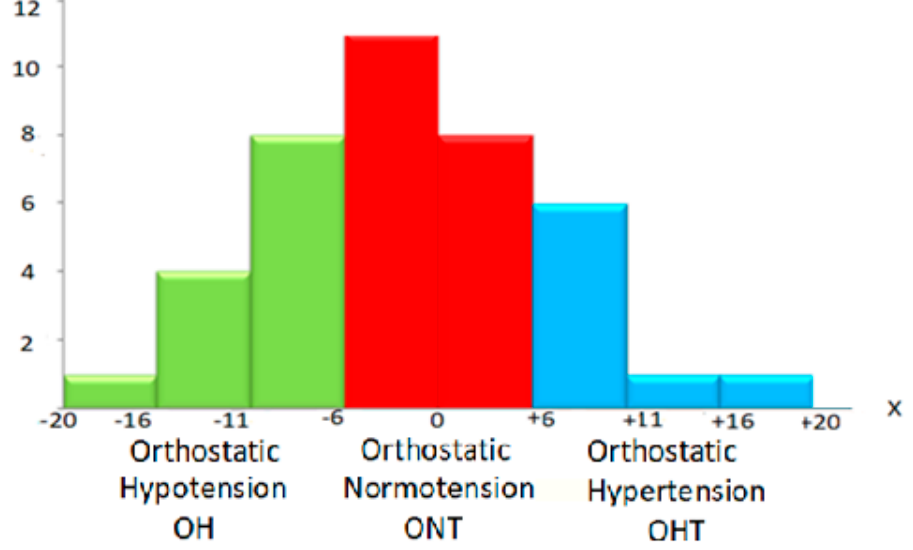
Figure 1. Distribution of subjects by orthostatic changes systolic blood pressure ( ∆ SBP). X —axis— ∆ SBP values, Y —axis—number of subjects in groups. ONT ± 5 mmHg (red columns), OH—6 − 20 mmHg. (green columns), OHT + 6 + 20 mmHg. (blue columns). The personalized ∆ SBP data with the above classification showed no orthostatic disorders only in 19 healthy subjects (48%), ∆ SBP corresponded to ONT, in 13 subjects (32%) ∆ SBP corresponded to OH and in 8 (20%) to